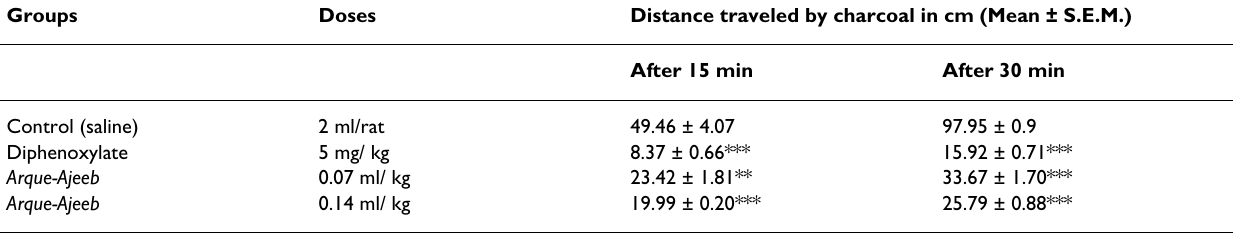
Table 2: Effect of AA on serotonin-induced diarrhoea Groups Doses % respondent Mean latent period in